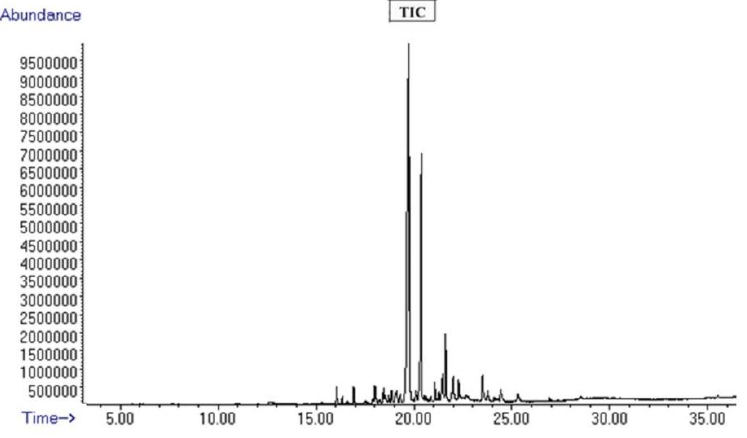
Figure 1. TIC chromatogram of curcuma extract.